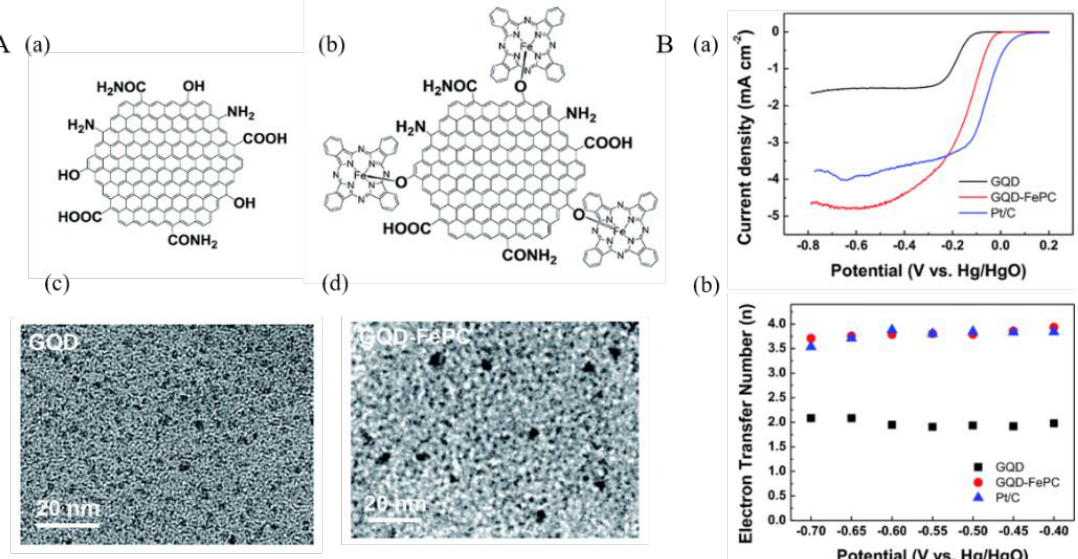
Figure 8. Chemical structures of ( A ) ( a ) graphene quantum dots (GQD) and ( b ) GQD-FePc. TEM images of ( c ) GQD and ( d ) GQD-FePC. ( B ) ( a ) LSC curves at 1600 rpm and ( b ) the electron transferred numbers of GQD, GQD-FePc, and Pt / C in O 2 -saturated 0.1 M KOH electrolyte adapted from ref [53] Copyright 2017 Royal Society of Chemistry.